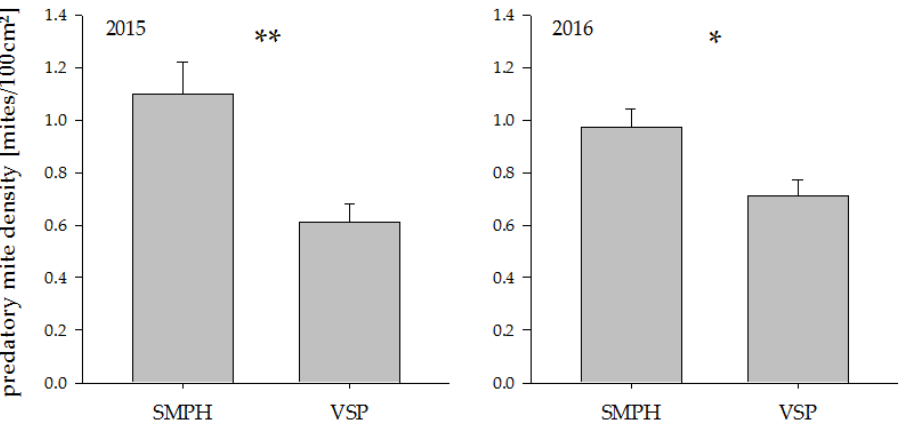
Figure 3. Predatory mite density in minimally pruned versus trellis-trained plots in the years 2015 and 2016. * indicate significant differences between groups (* p < 0.05, ** p < 0.005). Values represent means + standard errors (N = 24). SMPH: semi-minimal pruned hedge, VSP: vertical shoot positioning.